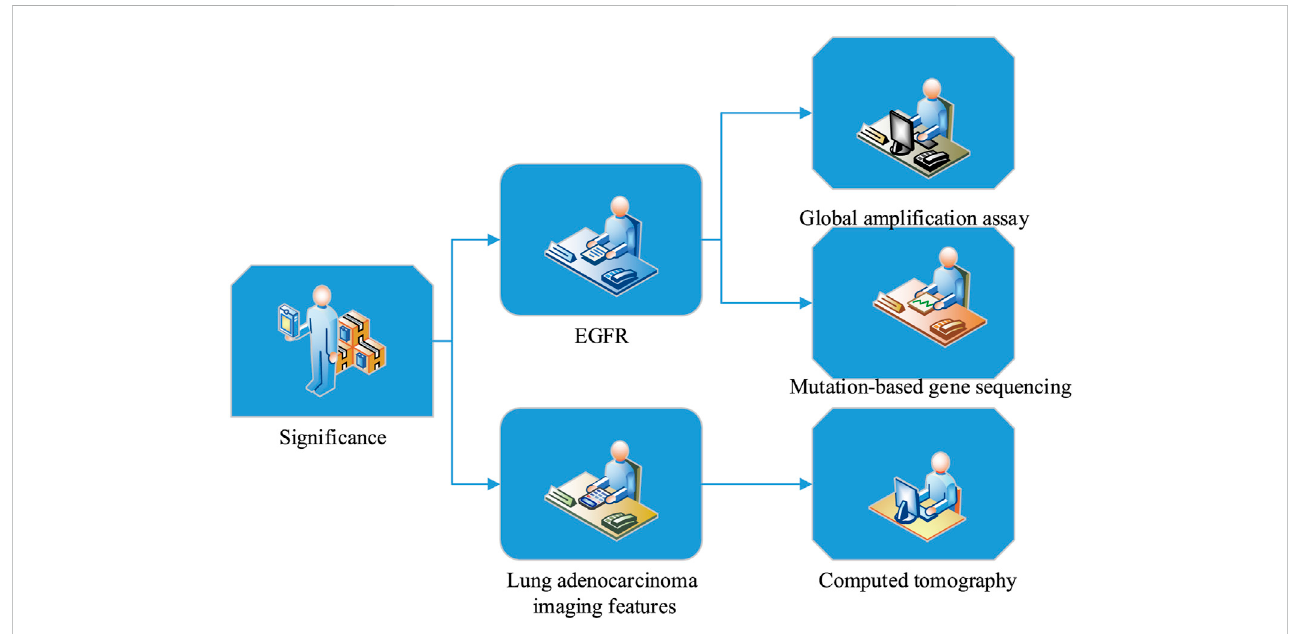
FIGURE 3 Signi fi cance of LUAD imaging features and EGFR gene mutation